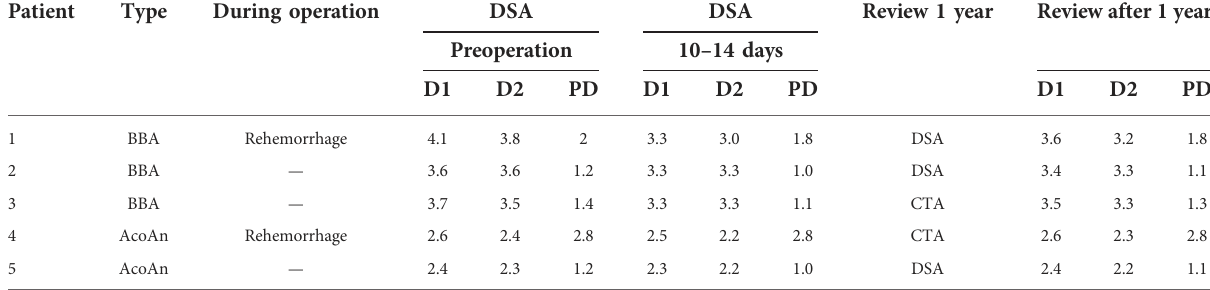
TABLE 1 Outcome of the IA treated using the CRYST